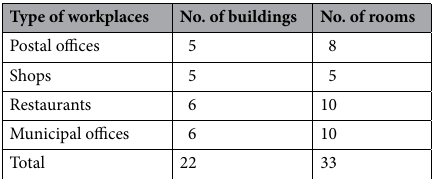
Table 1. Workplaces chosen for the